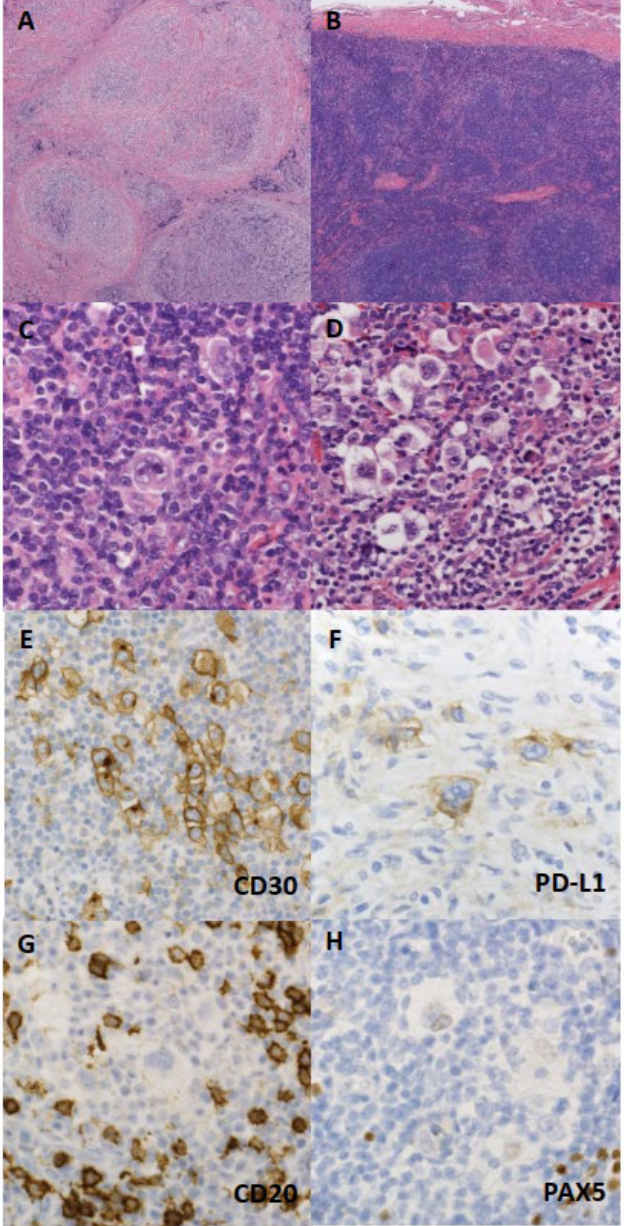
Figure 1. Histological and immunohistochemical features of nodular sclerosis classical Hodgkin lymphoma (NSCHL). ( A ) Cellular nodules are separated by collagen bundles. ( B ) Sclerotic thickening of the lymph node capsule is shown. ( C ) Neoplastic cells that are binucleated with a “mirror-image” appearance, called “Reed–Stenberg cells”. ( D ) Neoplastic cells with a lacuna-like space around the cytoplasm, called “lacunar cells”. ( E – H ) Neoplastic cells expressing CD30 and PD-L1 (assessed using clone SP142), lacking CD20 expression, and with very weak PAX5